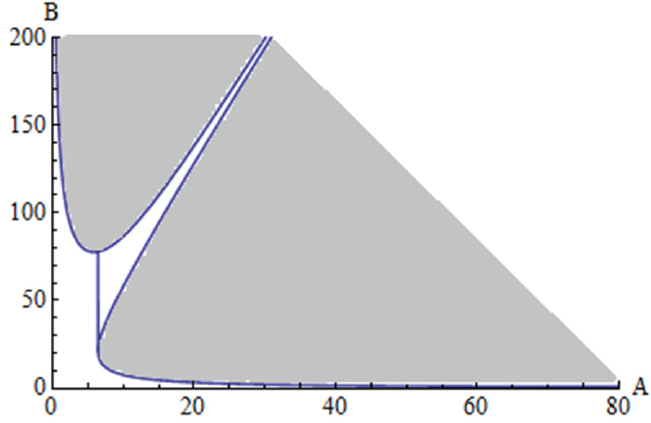
Figure 5. Stability domain for case 2 (shadow area): a 1 = 0.2, a 2 = 0.25, e 1 = 0.3, e 2 = 0.33. The boundary stability of the first tube is obtained from Equation (72). This boundary curve is 4 − λ 1 − λ 2 = 0, where λ 1 and λ 2 are given by Equations (83) and (89). On the other hand, the boundary curve of the second tube can be obtained from 4 − γ 1 − γ 2 = 0, where γ 1 and γ 2 are given by Equations (84) and (90). The area of stability for the